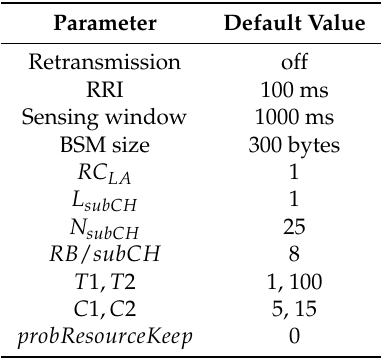
Table 1. Parameters used in